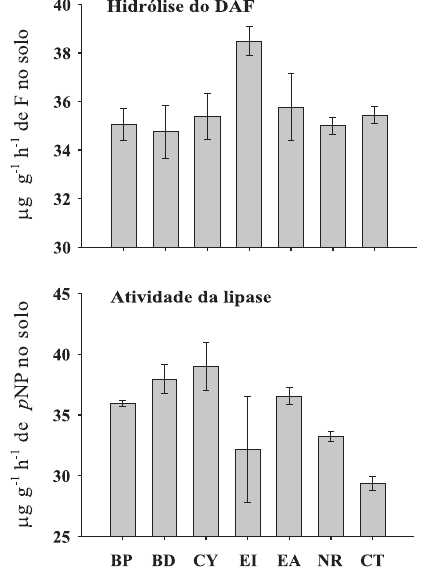
Figura 2. Atividade enzimática (hidrólise do diacetato de fluoresceína – DAF e atividade da lipase) em solos rizosféricos de plantas de crescimento espontâneo em área de “landfarming” de resíduos petroquímicos, sendo p NP para -nitrofenol e F fluoresceína. BP ( Bidens pilosa ), BD ( Brachiaria decumbens ), CY ( Cyperus sp.), EI ( Eleusine indica ), EA ( Eclipta alba ), NR (Solo não-rizosférico) e CT (Solo- controle sem planta). Linhas verticais indicam o erro-padrão da média (n = 3).